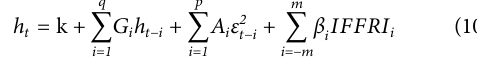
8 White noise: a purely random process with expectation of 0 and a constant